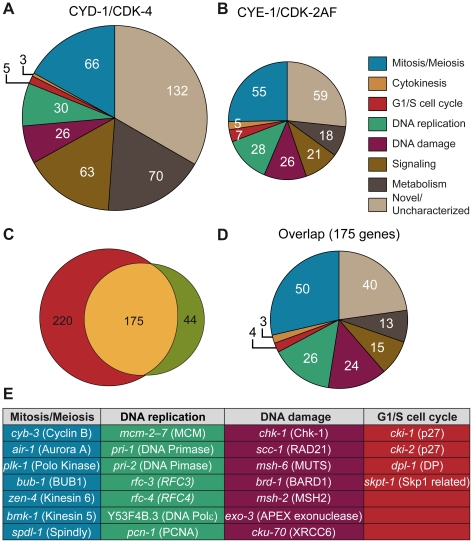
Microarray analysis reveals induction of cell-cycle gene transcripts in differentiated muscle cells.(A,B) Functional annotation of genes significantly increased more than 2-fold in Pmyo-3::CYD-1/CDK-4 and Pmyo-3::CYE-1/CDK-2AF muscle cells. A large overrepresentation of genes involved in various stages of the cell cycle is seen in both data sets, as well as a distinct increase in the proportion of metabolism and signaling genes in CYD-1/CDK-4 animals. (C) Overlap in more than 2-fold upregulated genes between CYE-1/CDK-2AF and CYD-1/CDK-4 body-wall muscle cells. The majority of the genes induced by CYE-1/CDK-2AF are also induced in CYD-1/CDK-4, but the latter also contains a substantial number of non-cell cycle genes. (D) Functional annotation of the genes present in the overlap between CYD-1/CDK-4 and CYE-1/CDK-2AF reveals a strong (60%) representation of known cell cycle genes. (E) Table of representative cell cycle genes and their orthologs that are induced by both CYD-1/CDK-4 and CYE-1/CDK-2AF (>2-fold upregulated).